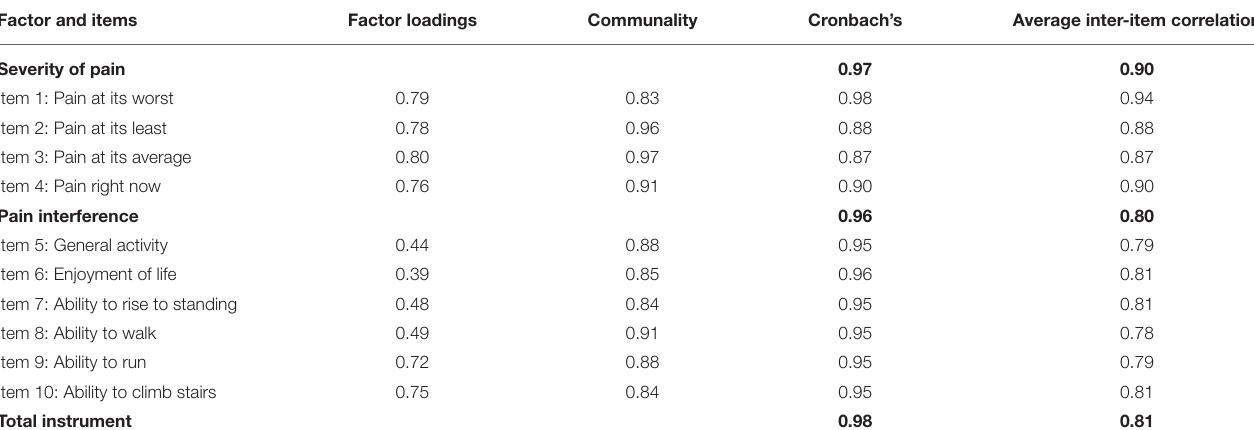
TABLE 2 | Factor loadings and communality of each item of the Italian Canine Brief Pain Inventory. Cronbach’s α coefficient and average inter-item correlation of the severity of pain domain and pain interference with function domain, as well as the total instrument. Factor and